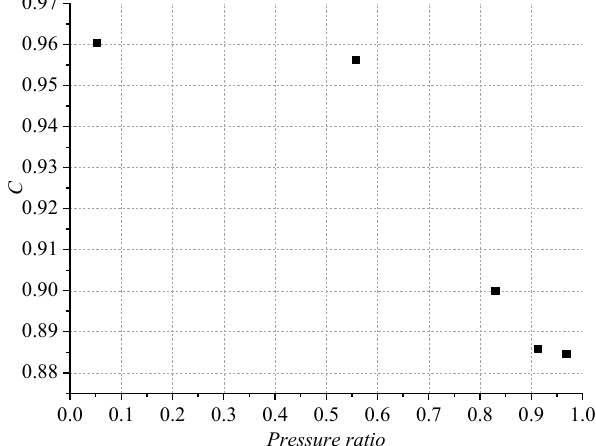
Figure 7. The variation curve of C with pressure ratio based on Kim’s experiment.